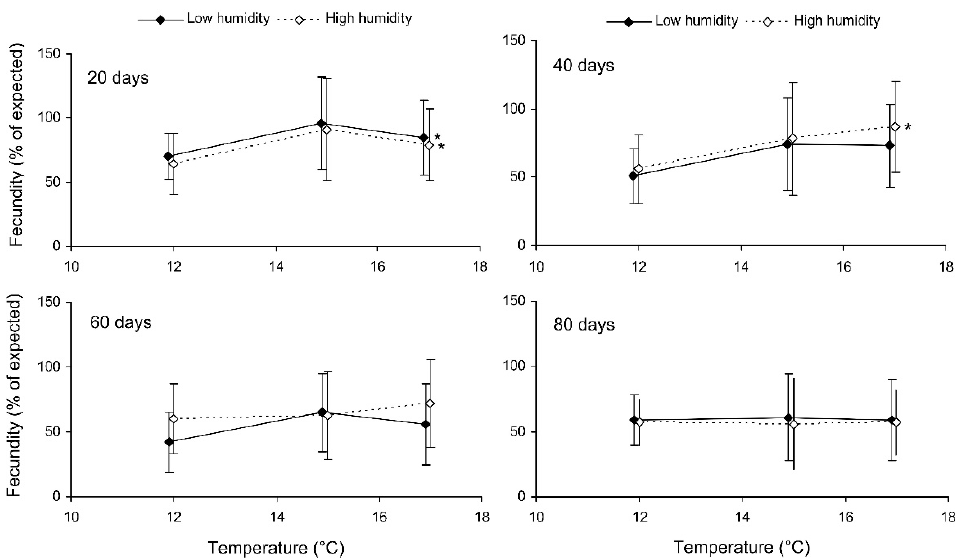
Figure 5. Fecundity of fed Cheilomenes propinqua females in relation to the temperature, humidity, and duration of storage (the results of the long-term experiment). The means and SD of the percentage of the expected fecundity calculated based on the females’ size are shown. The duration of storage is indicated in the graphs. Asterisks at the right end of the line indicate a significant influence of temperature, *— p < 0.05, according to a one-way ANOVA test.